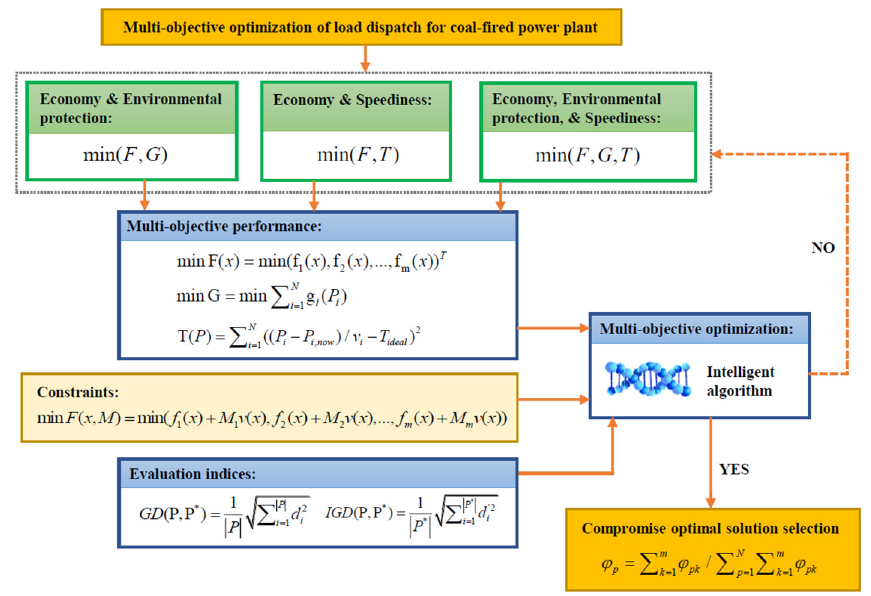
Figure 1. Sequence diagram of multiobjective optimization of load dispatch of coal-fired power plant.